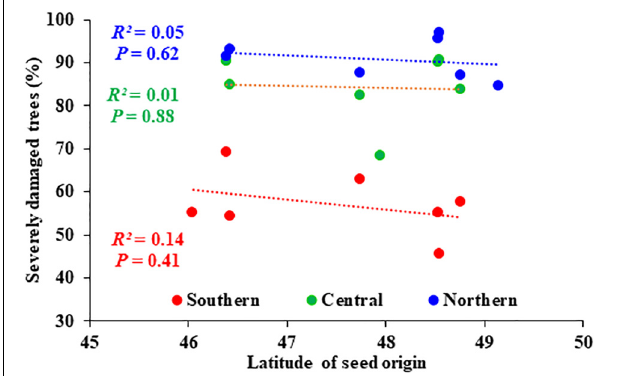
FIGURE 6 | Relationship between the proportion of damaged trees by the late-spring frost of 2021 and the latitude of seed origins ( n = 7 that is, the 6 tested seed sources across sites and the local seed source at each site) in the three plantation tested sites; (Southern, Central, Northern). Regression lines were not significant with P ≥